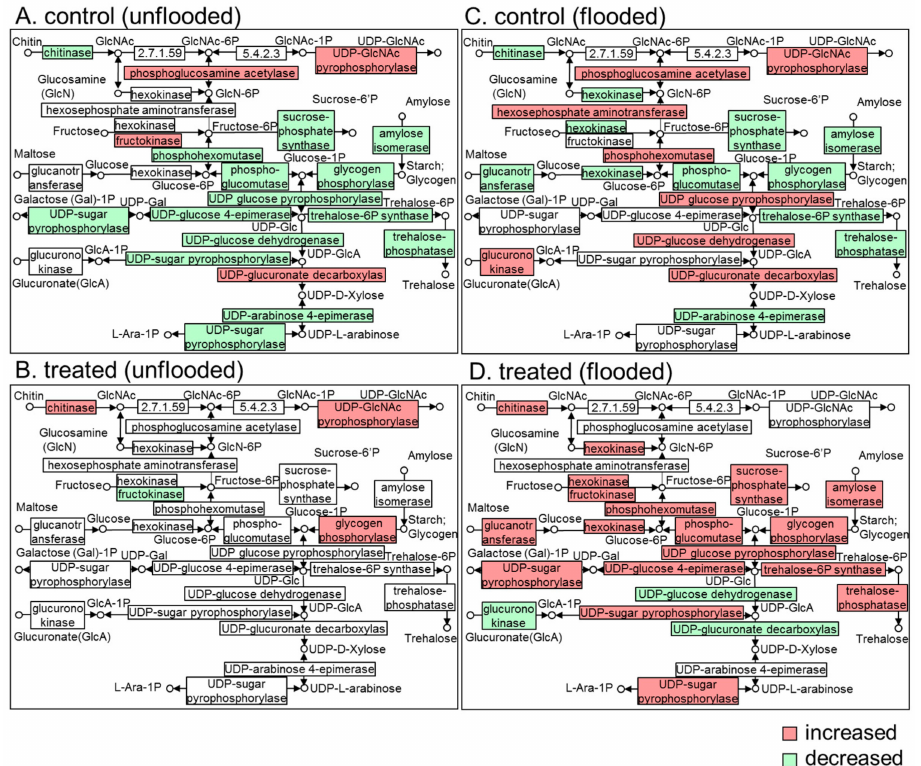
Figure 6. Mapping of di ff erentially changed proteins in soybean root related to sugar metabolism. Proteins were identified from soybean seedlings treated without or with millimeter-waves irradiation under flooded and unflooded conditions. Pathway map was determined on KEGG